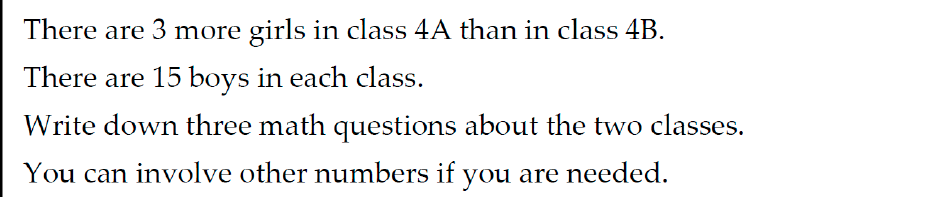
Figure 1. The task of filing mathematical problems.